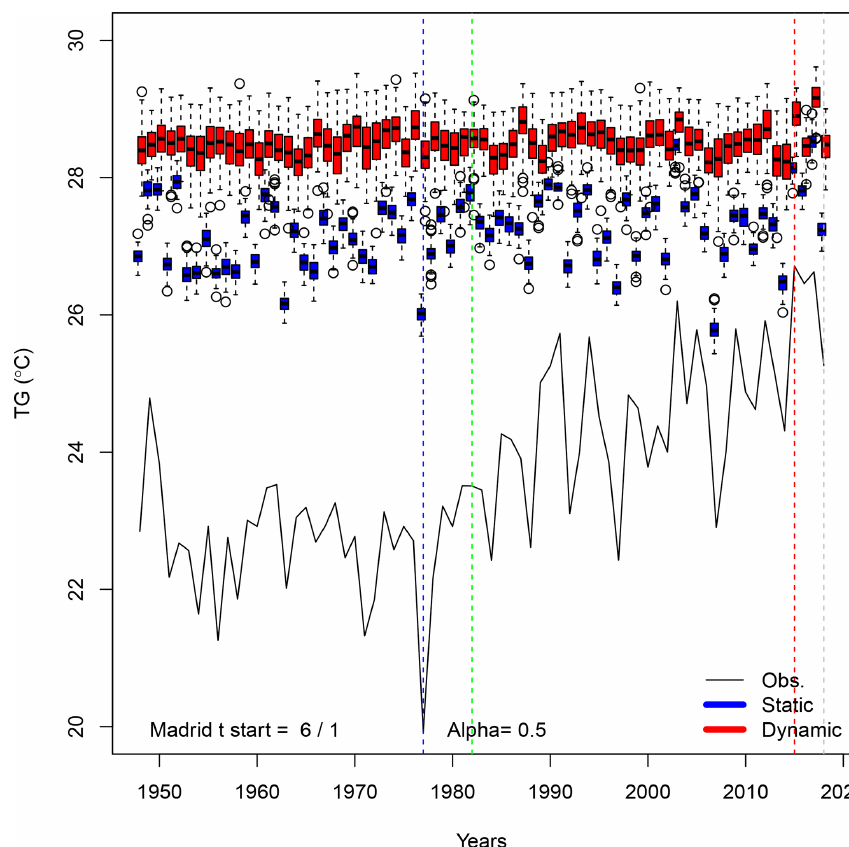
Figure C1. Time variations of probability distributions of simulated average temperatures (TG) for α TG = 0 . 5 in Madrid. The black con- tinuous line represents the observed variations in Orly summer averages between 1948 and 2018. Temperatures are expressed in degrees Celsius. The vertical colored lines outline the coldest (blue), median (green), warmest (red) and 2018 summers. The box plots represent the ensemble variability of the simulations for each year. The red box plots are for the dynamic simulations. The blue box plots are for the static simulations. The boxes of box plots indicate the median ( q 50 ), lower ( q 25 ) and upper ( q 75 ) quartiles. The upper whiskers indicate min [ max (T ), 1 . 5 × (q 75 − q 25 ) ] . The lower whisker has a symmetric formulation. The points are the simulated values that are above or below the defined